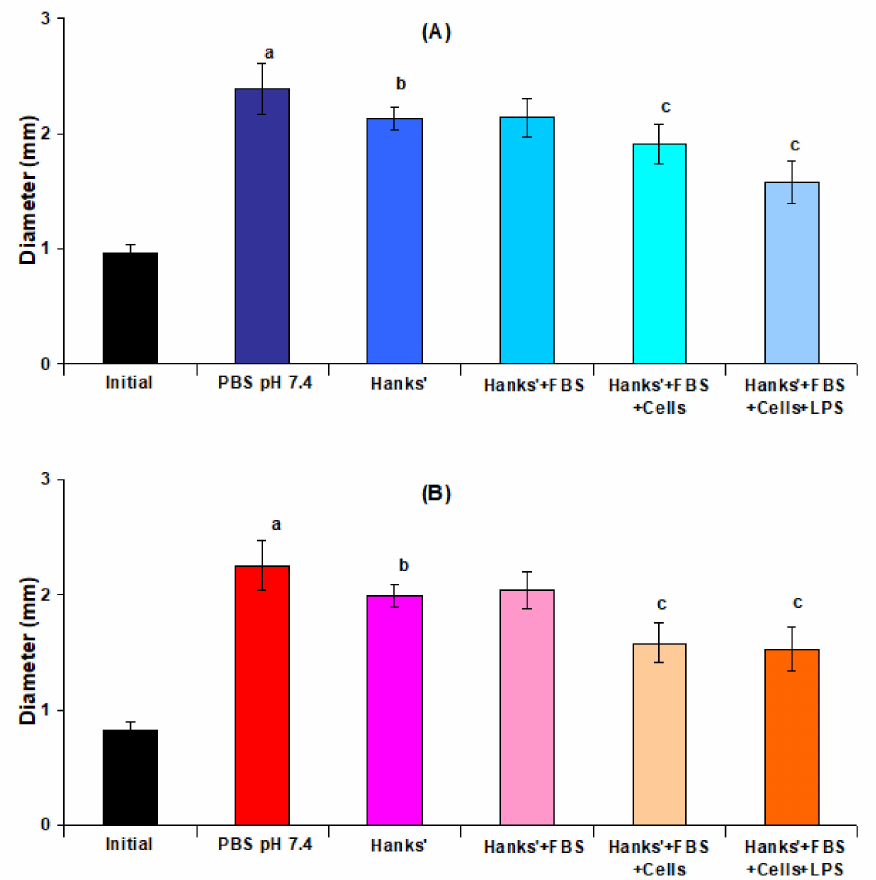
Figure 7. Effect of composition of incubating medium on the swelling of AP4 ( A ) and HS4 ( B ) gel beads. Dried gel beads (“Initial”) were incubated for 4 h in PBS (“PBS” pH 7.4); Hanks’ solution at pH 7.4 (“Hanks’”); Hanks’ solution supplemented with 10% fetal bovine serum (“Hanks’+FBS”); Hanks’ solution supplemented with 10% fetal bovine serum and 2 × 10 6 cells/mL peritoneal macrophages (“Hanks’+FBS+Cells”); Hanks’ solution supplemented with 10% fetal bovine serum, 2 × 10 6 peri- toneal macrophages, and 10 µ g/mL of lipopolysaccharide (“Hanks’+FBS+Cells+LPS”). The data are presented as the mean ± S.D. (n = 12). a p < 0.05 vs. “Initial”; b p < 0.05 vs. PBS pH 7.4; c p < 0.05 vs.